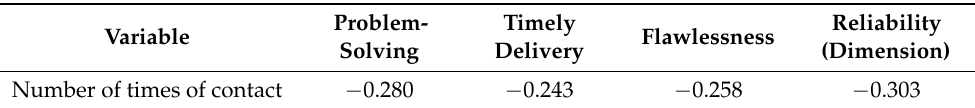
Table 4. Pearson correlation coefficients for the reliability dimension and its three features. All correlations are significant at the 0.01 level (2-tailed).